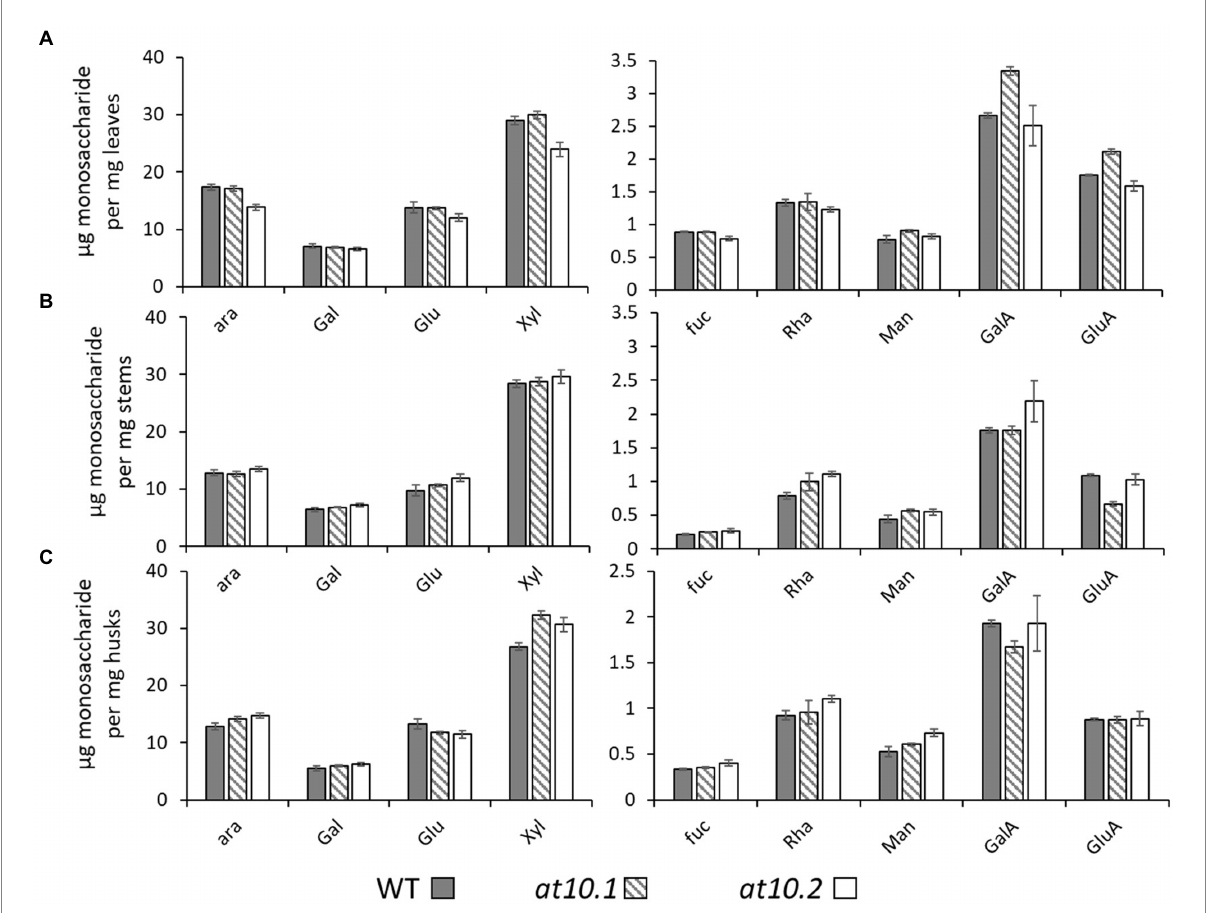
FIGURE 5 Monomeric sugar analysis. μ g of Monomeric sugars pr. mg dry material released by TFA. Material was taken from leaves (A) , stems (B) and husks (C) . WT is shown as Gray bars, OsAT10.1 Hatched bars and OsAT10.2 White bars. Error bars represent standard deviation. Student’s t-test was run between WT and both mutants to check for significance.